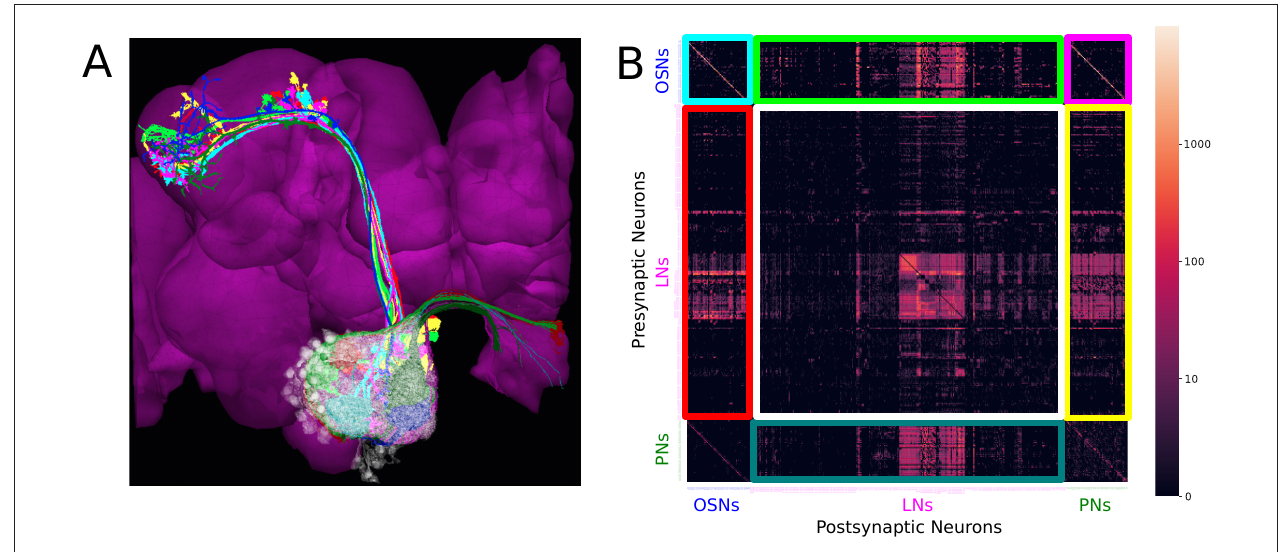
FIGURE 1 | Massive number of feedback loops in the Antennal Lobe. (A) Antennal Lobe circuit involving OSNs (darker colors), PNs (brighter colors) and LNs (transparent white). Select OSNs, PNs and LNs are shown. (B) The adjacency matrix of the connectivity graph of the neurons in the AL, with all OSNs expressing the same OR merged into a single neuron group node, and all PNs in the same glomerulus merged into a single neuron group node. Matrix elements indicate the number of synapses from a presynaptic neuron (or neuron group) to a postsynaptic neuron (or neuron group). Magenta block on top right: submatrix of the feedforward connectivity from OSNs to PNs in each glomerulus. Green block on the top: submatrix of the feedforward connectivity from OSNs to LNs. Blue block on the bottom: submatrix of the connectivity from PNs to LNs. Red block on the left: submatrix of the feedback connectivity from LNs to OSNs. Yellow block on the right: submatrix of the feedback connectivity from LNs to PNs. White block in the middle: submatrix of the connectivity between